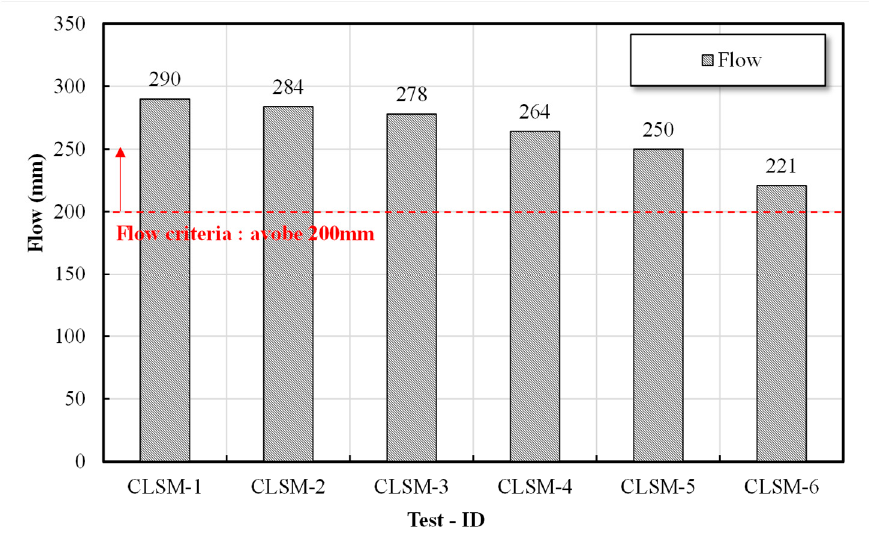
Figure 3. Flow test results based on the W/B.